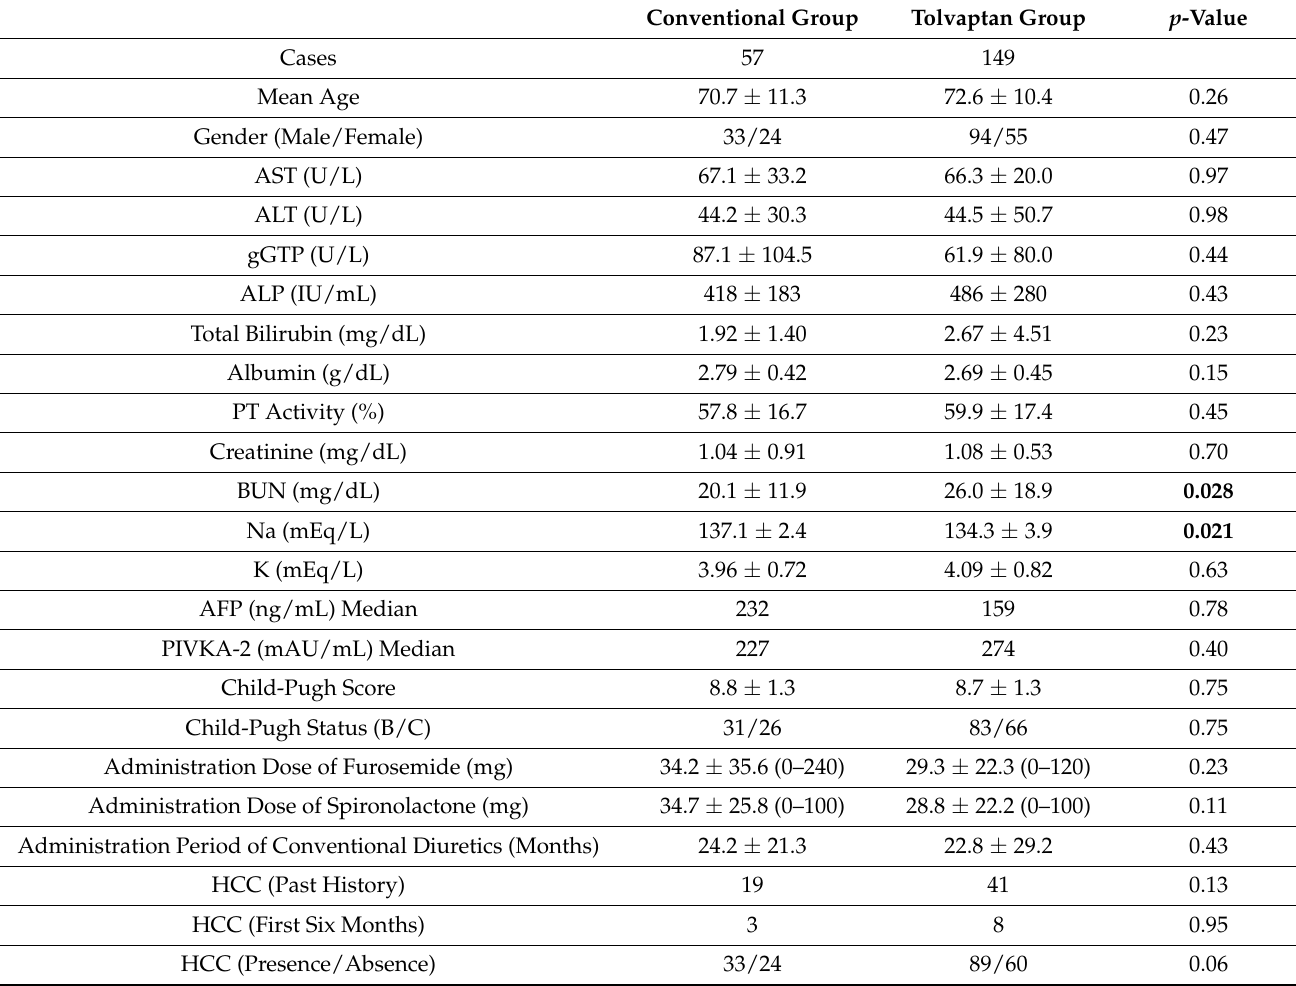
Table 1. Clinical backgrounds in the conventional therapy group and the tolvaptan group enrolled in this